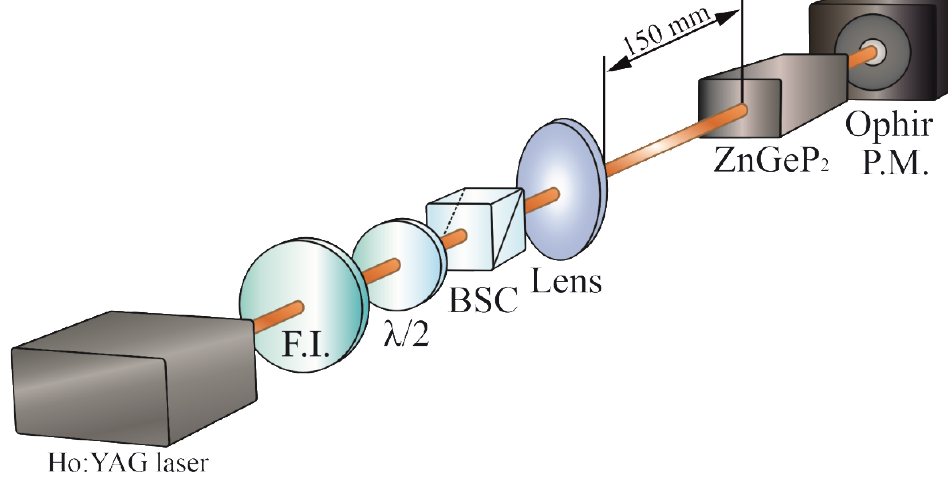
Figure 6. Scheme of the experimental setup for determining LIDT.